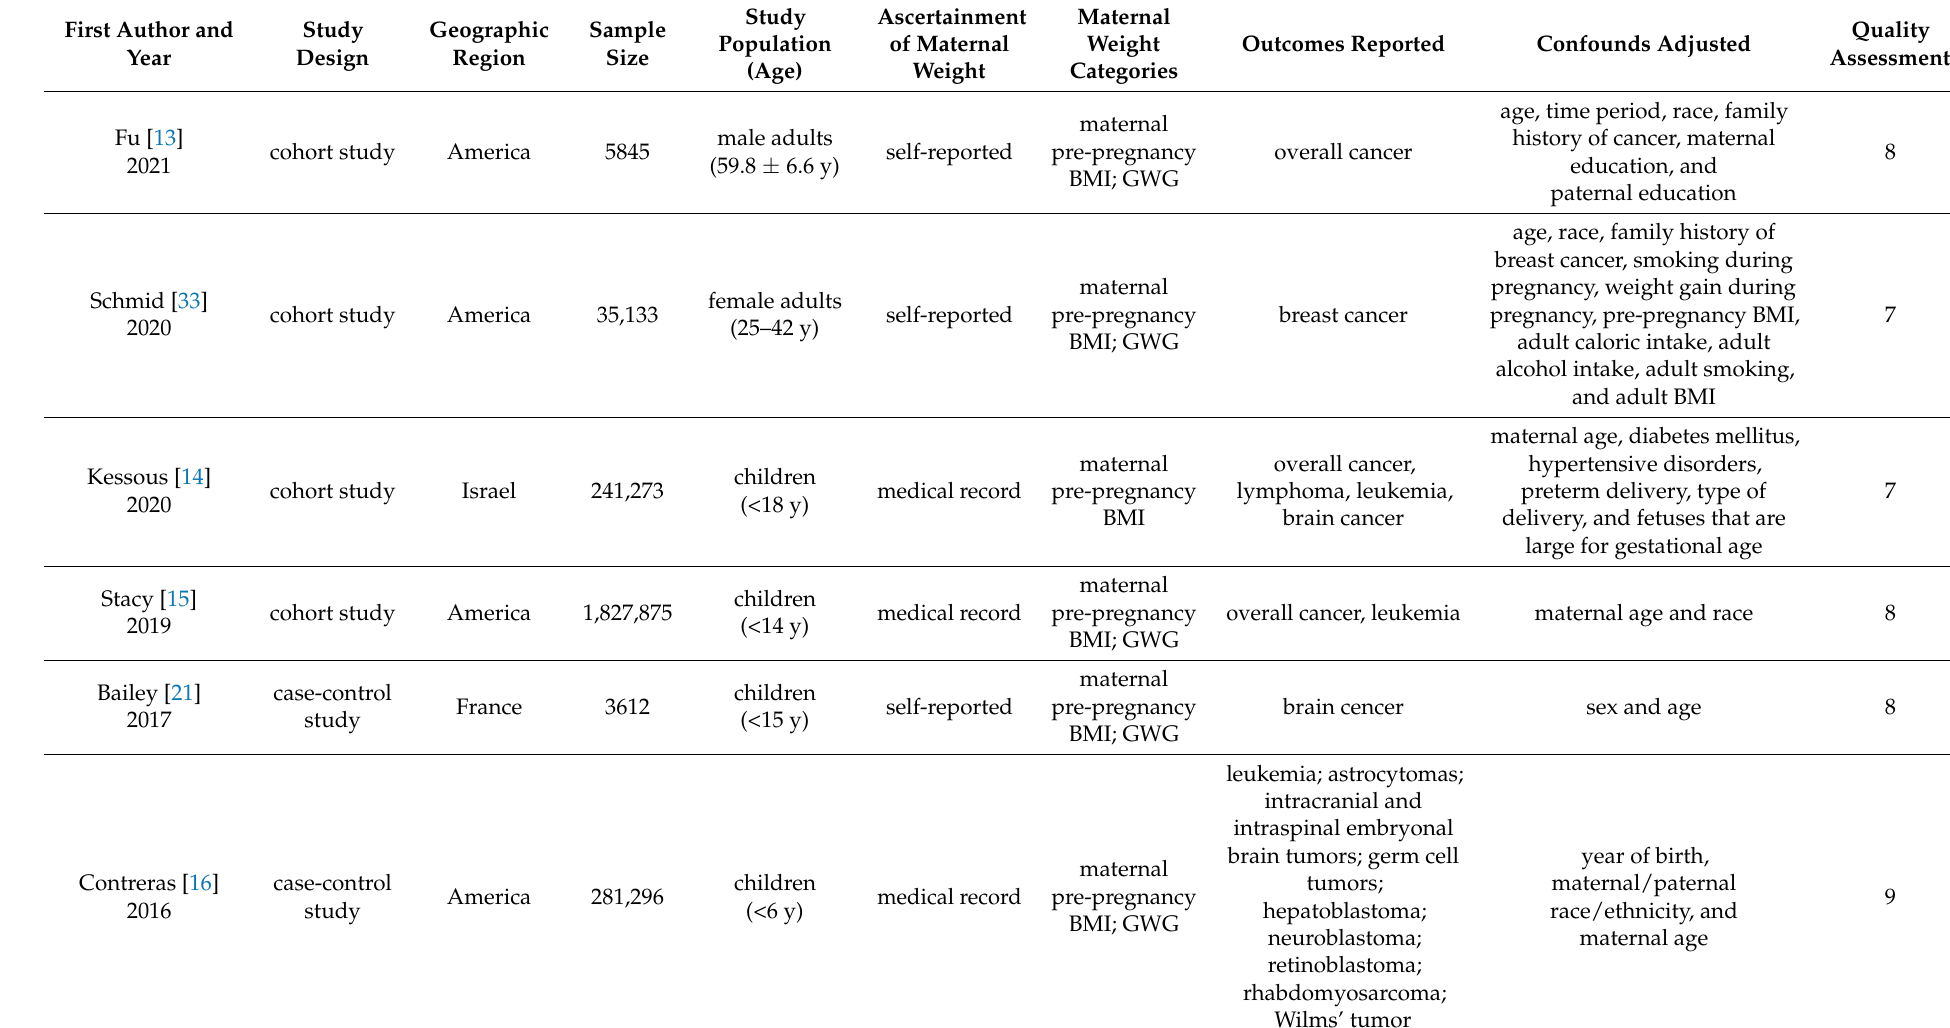
Table 1. Selected characteristics of twenty-one